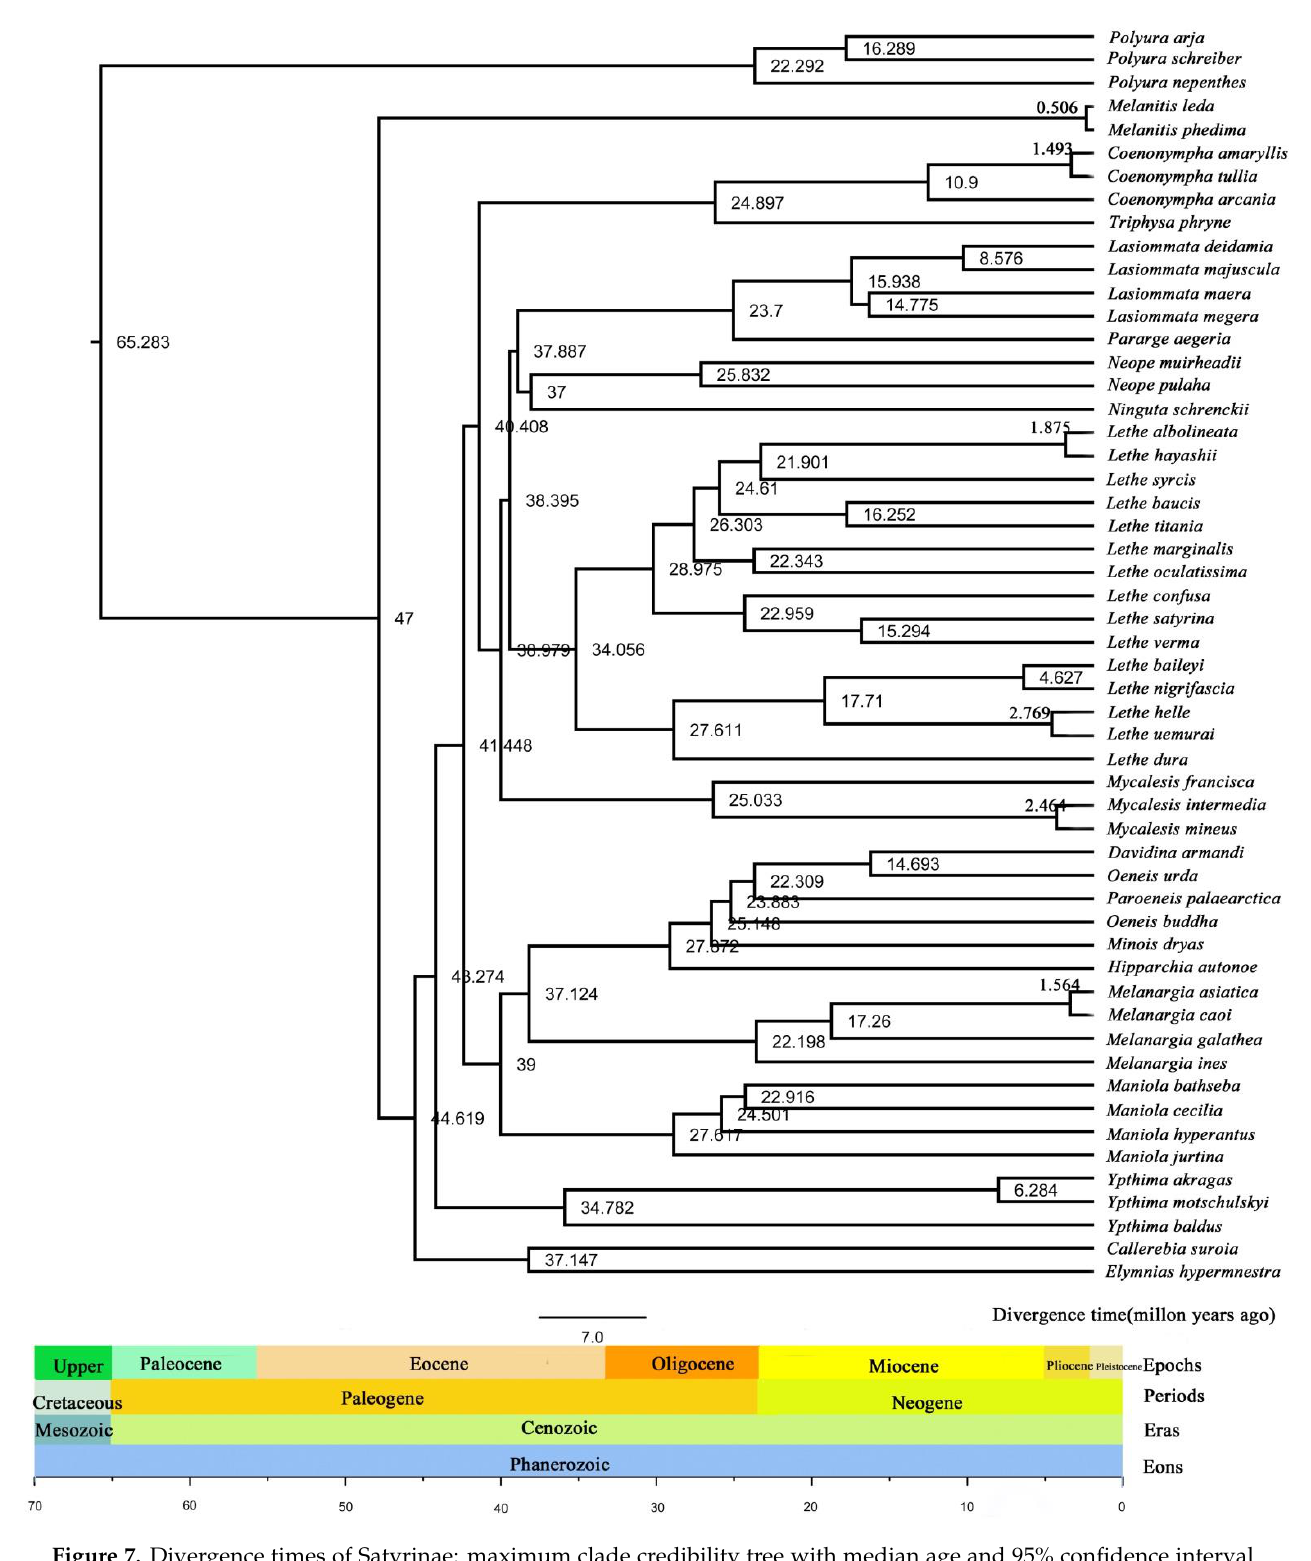
Figure 7. Divergence times of Satyrinae: maximum clade credibility tree with median age and 95% confidence interval estimated using a Bayesian uncorrelated relaxed clock implemented in r8s.